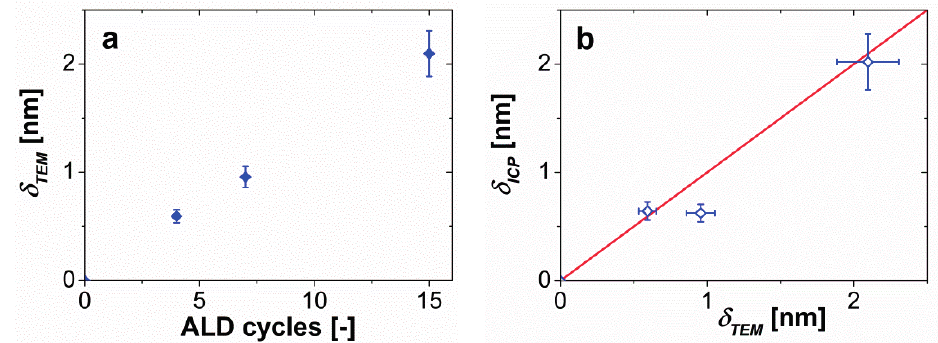
Figure 2. ( a ) Thickness of the alumina film, determined from TEM images, for the different number of cycles for a dosing sequence of 3.5–10–2.5–10 min. The error bars represent the 10% error assumed in the image analysis; ( b ) Comparison of the film thickness from TEM images and ICP-OES measurements for a density of alumina of 2500 kg/m 3 . The horizontal error bars represent the 10% error in the image analysis, while the vertical error bars show the error made in the calculation of the thickness, which accounts for the size of TiO 2 particle, the experimental error of the ICP-OES device (3%) and the density of the alumina. The red line represents ideal agreement between the